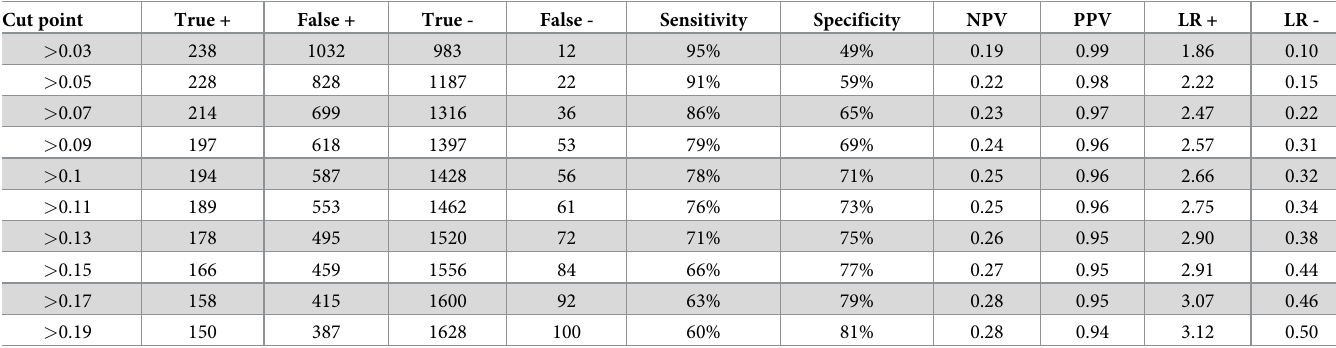
Table 4. Clinical performance of the logistical model for predicting COVID-19 severity � in the real-time validation data set (n = 2174). Cut point True + > 0.03